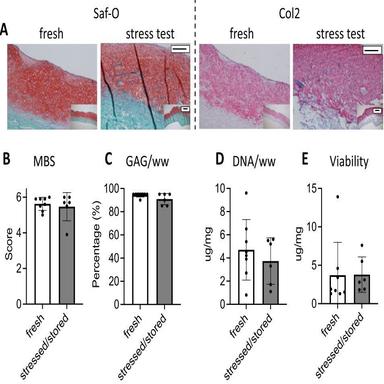
Representative Safranin-O (Saf-O) and type II collagen (Col2) images of N-TEC generated with the modified process at day of release (fresh) as well as 3 days after stress/storage conditions (stressed/stored). Histological slides are oriented in the way to have on the top view the newly deposited cartilage matrix (in the seeded cell-permeable layer of the ChondroGide membrane; the lower part of the N-TEC (appearing in bluish green in the Saf-O-pictures) represents the cell occlusive layer). Scale bars = 100